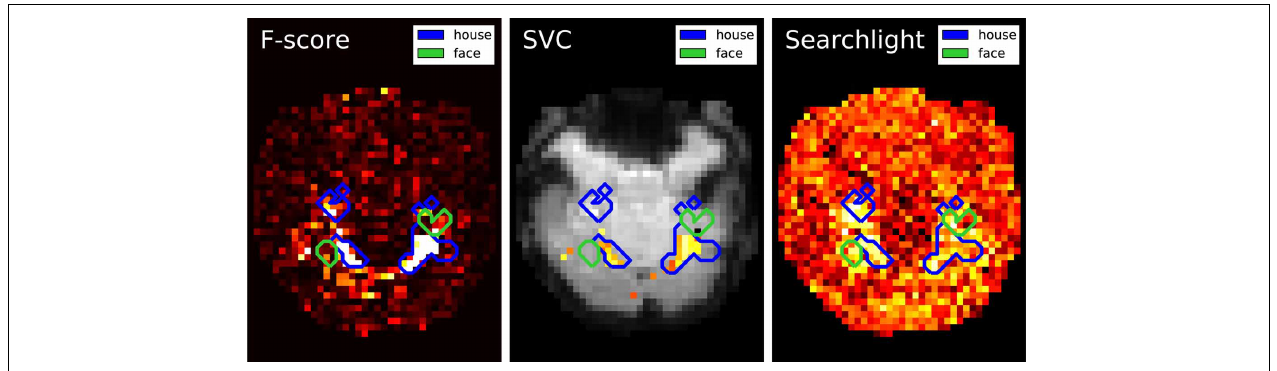
FIGURE 2 | Maps derived by different methods for face versus house recognition in the Haxby experiment— left : standard analysis; center : SVM weights after screening voxels with an